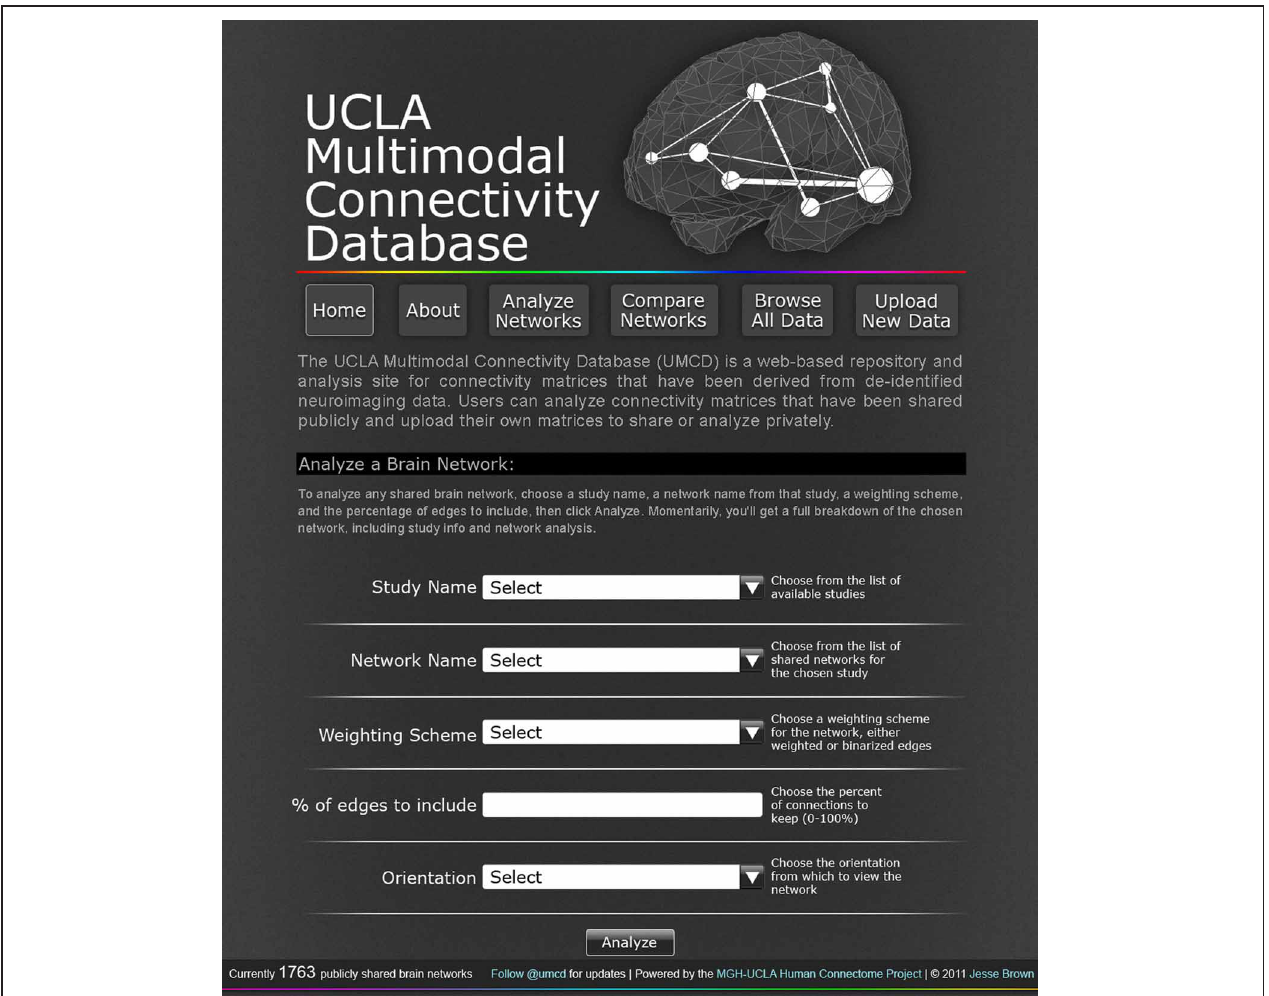
that study will appear in the “Network Name” dropdown menu. After selecting an individual network to analyze, the user must specify a “Weighting scheme” and “% of edges to include” for the analysis, choose an orientation in which to render the analysis-based network images, and click